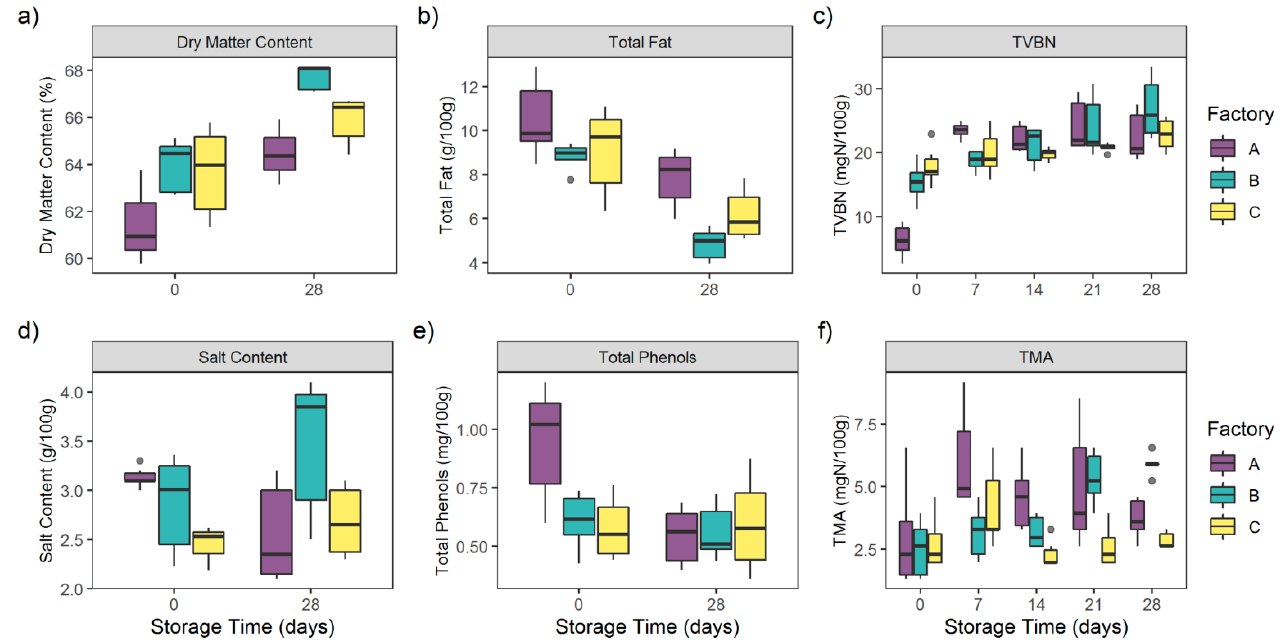
Figure 2. Evolution of ( a ) dry matter content (%), ( b ) total fat (g/100 g), ( c ) total volatile basic nitrogen (TVBN) (mgN/100 g), ( d ) salt content (g/100 g), ( e ) total phenols (mg/100 g), ( f ) trimethylamine (TMA) (mgN/100 g) of 45 CSS products during 28 days of storage.